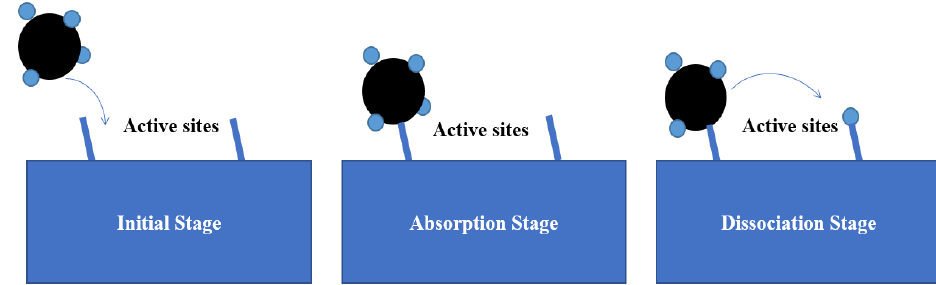
Figure 7. Schematic diagram of the methane non-dissociative absorption mechanism model.